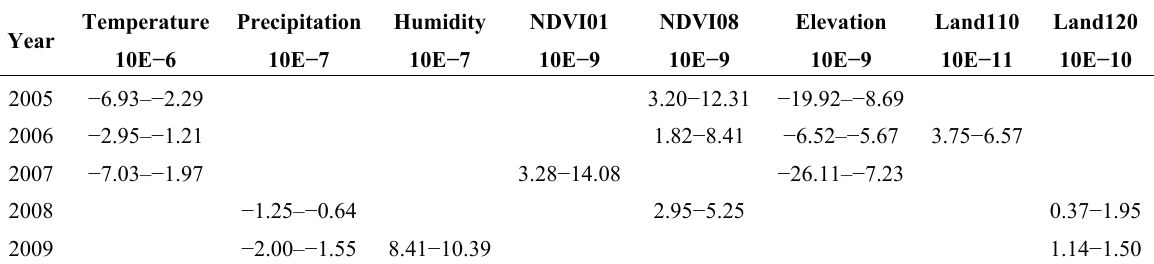
Table 5. The GWR model coefficients,